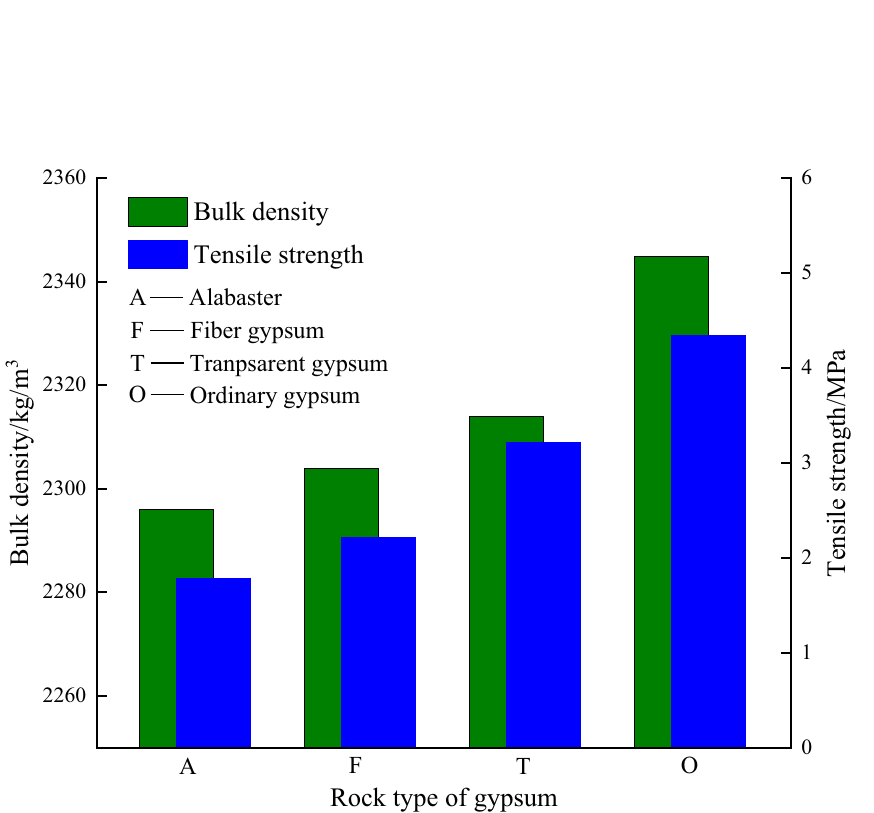
Figure 6. Tensile strength and density of the four types of gypsum rocks: alabaster, fiber gypsum, transparent gypsum, and ordinary